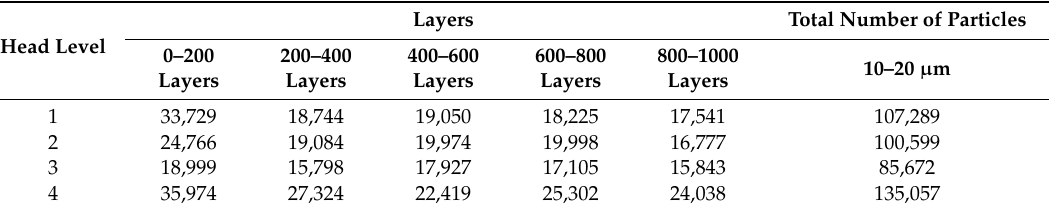
Table 12. Variation in the number of fine particles percolated with the 50% fine particle content (10–20 µ m).